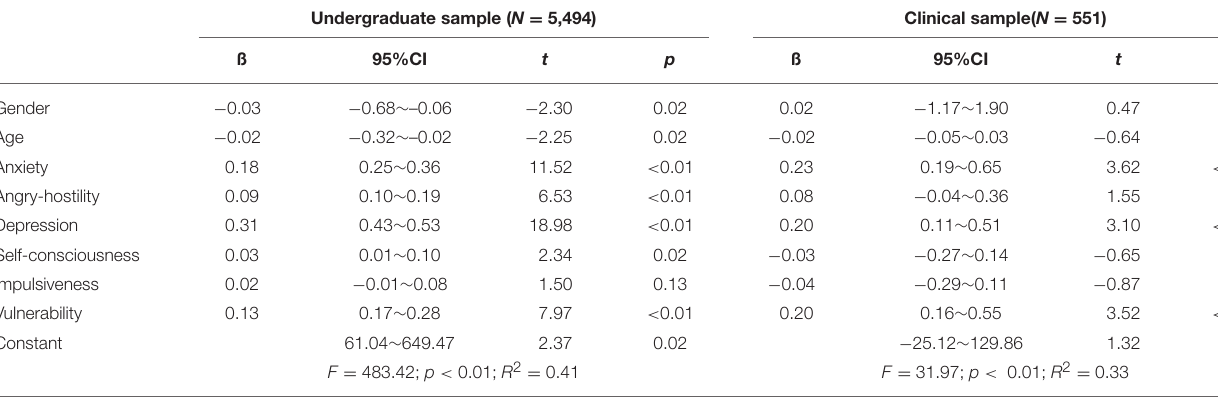
TABLE 7 | Multiple regression analysis with the CES-D total score as the dependent variable.